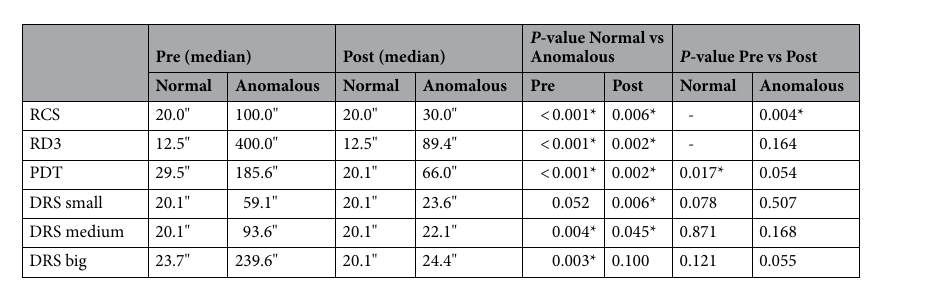
Figure 1. Stereoacuity transfer after training for clinical and psychophysical tests. ( A ) Improvement in clinical stereoacuity as a function of initial RCS (filled symbols) and RD3 (open symbols) threshold and comparison with Ding & Levi, 2011 (upside-down triangles) and Vedamurthy et al., 2016 (right-side up triangles). ( B ) Psychophysical stereoacuity improvement as a function of initial stereo threshold for PDT (triangle), DRS small (small circle), DRS medium (medium circle) and DRS big (big circle). In both figures, colors indicate binocular condition: anisometropia (blue), strabismus (red), stereo-weak (green), and normal stereo (grey). Data under the unity line indicate an improvement in stereoacuity.